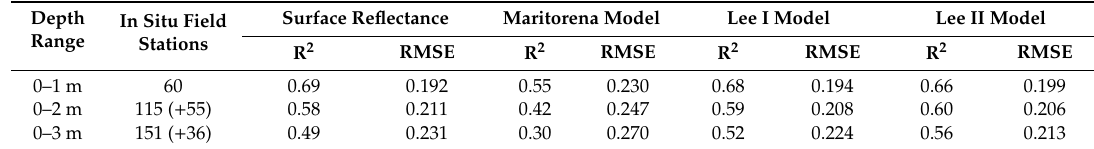
Table 2. The coe ffi cients of determination (R 2 ) and root mean square error (RMSE) between the reflectance at the 551.5 nm and community level submerged aquatic vegetation percent cover for the water surface reflectance and bottom reflectance produced by the Maritorena and Lee water column correction